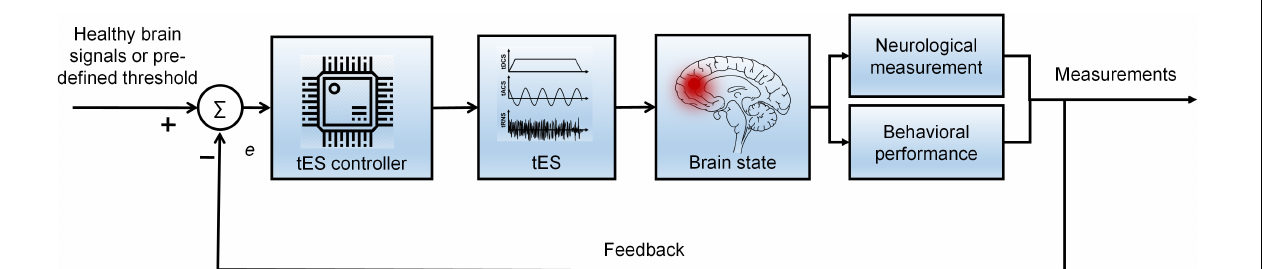
FIGURE 9 | Diagram of the proposed closed-loop tES